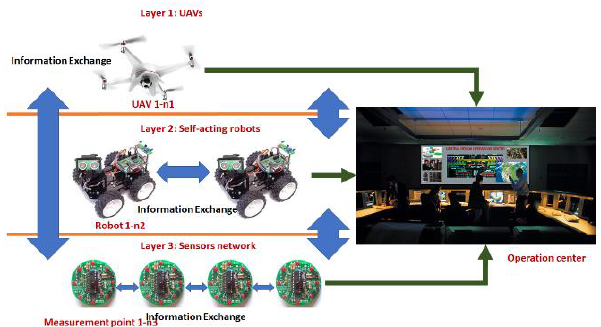
Figure 1. Three-layer structure of "Public safety network and emergency alarm"